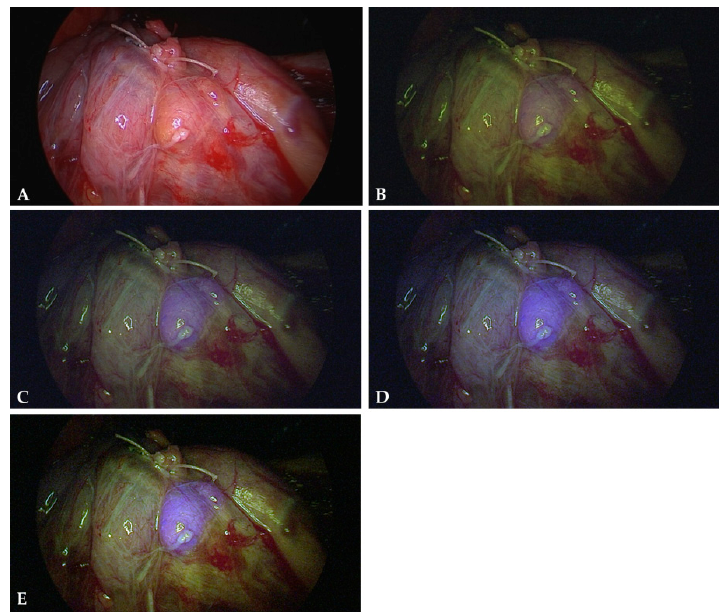
Figure 6. Contrast improvement by simple image processing: original white light ( A ) and NIR- autofluorescence image of a normal parathyroid gland ( B ). ( C and D ): full image brightness and contrast adjustments for the blue channel yield a much clearer discrimination of the parathyroid. An additional nonlinear gain setting for the blue channel (gamma set to 1.5) further improves the contrast ( E ). In this example, the contrast of blue intensity in the parathyroid versus green intensity in adjacent tissue could be increased from 0.85 ( B ) to 1.63 ( E ).